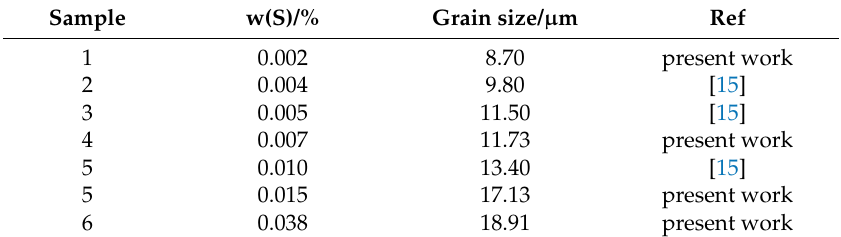
Table 3. Relationship between sulfur content and mechanical properties: yield strength (Re), tensile strength (Rm), elongation (A), and the Charpy-V type notch impact absorption work (Akv).